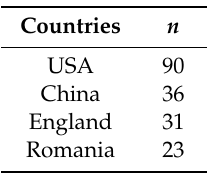
Table 8. Countries of AI documents.